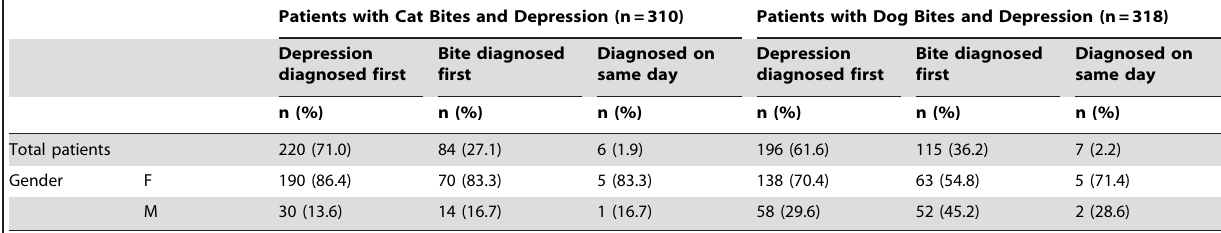
Table 4. Temporal relationships among the time of first diagnosis of depression and cat or dog bites.